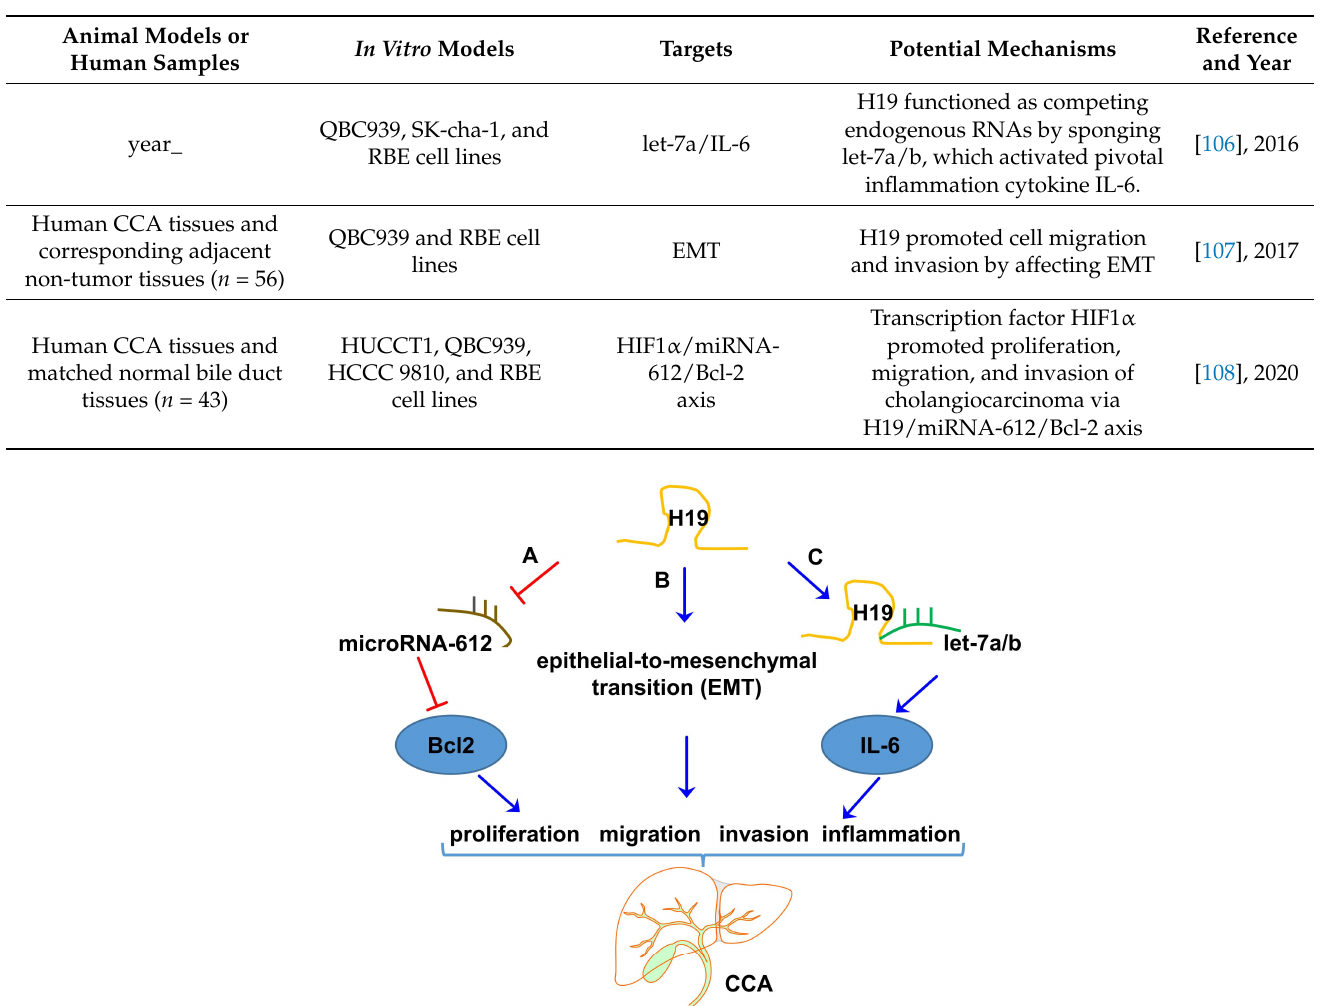
Table 3. Potential targets of lncRNA H19 in CCA.